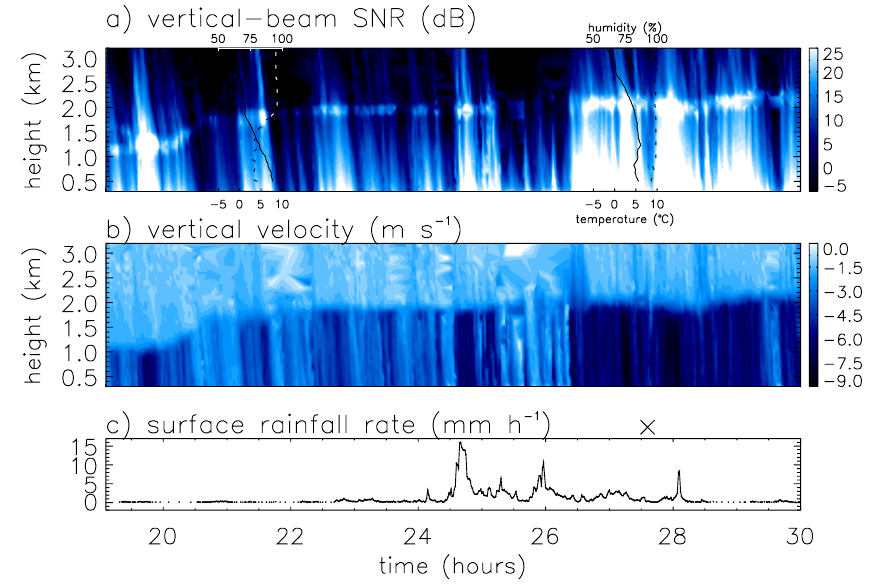
Fig. 4. Measurements during night of 27–28 February 2002, co-located with MU radar. (a, b) Conventional height-time plots from a 1357MHz boundary-layer radar. (a) vertical-beam signal-noise ratio with brightband at 1–2km AGL. Overplotted lines are relative humidity (dotted lines, upper scale, units of %) and temperature (solid lines, lower scale, units of ◦ C) from radiosondes launched 2117 and 0310 JST. (b) Vertical velocity showing fall speed of precipitation increasing below brightband. (c) Surface rain rate; dots near 0mmh − 1 show drizzle, zero rain rate is not plotted, and the time of Fig. 5 is marked as × .